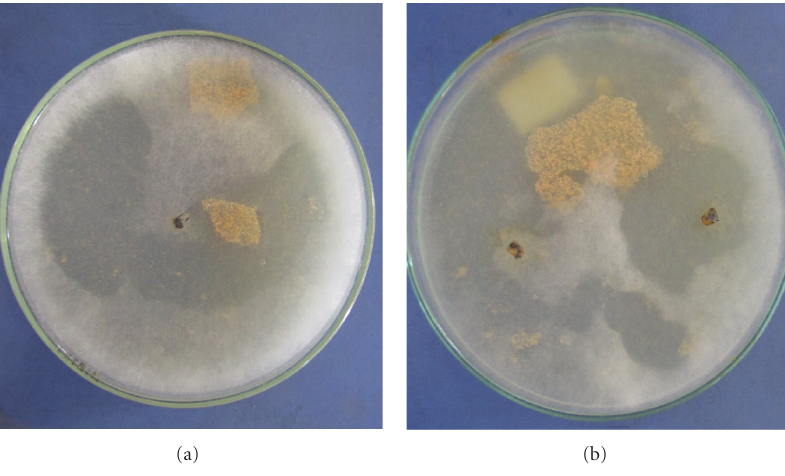
Figure 4: Phytophthora infestans was observed from peat moss (a) and seeds (b). Table 1: E ffi cacy of biocontrol, S . rubrolavendulae S4 on suppression of tomato and chili seedling damping o ff disease caused by Phytophthora infestans under greenhouse conditions.